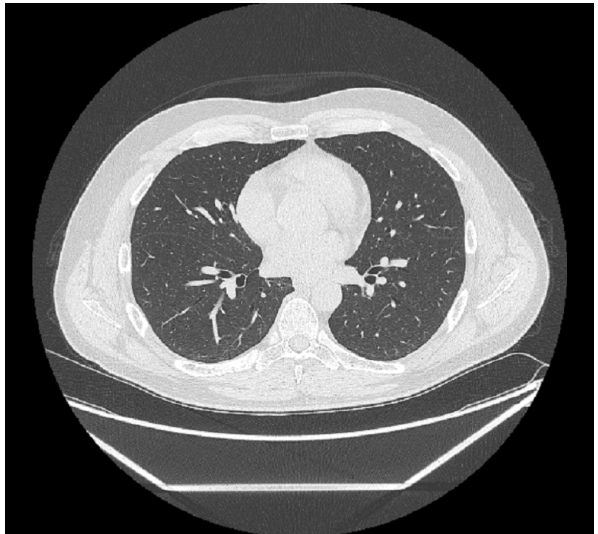
Figure 5. HRCT scan of a healthy patient. The image shows an example of healthy lung